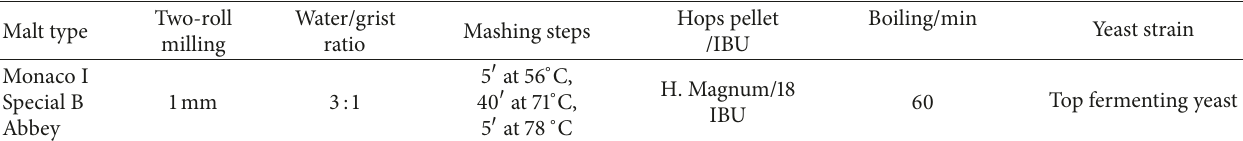
Table 1: Mashing schedule performed for wort